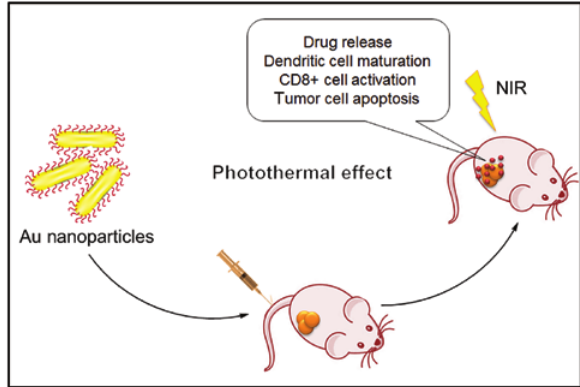
Figure 3: Macrolide modified gold nanorods for activation of immune response through the photothermal